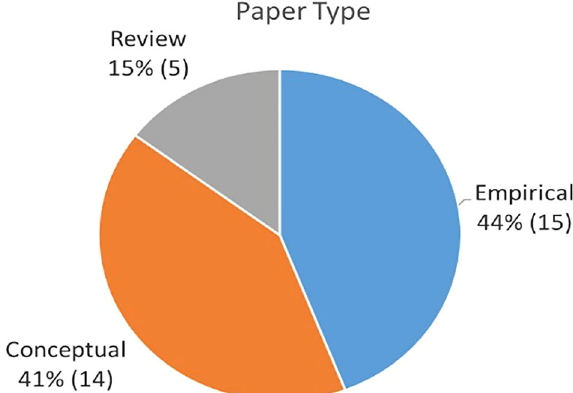
Figure 6. Percentage of paper by